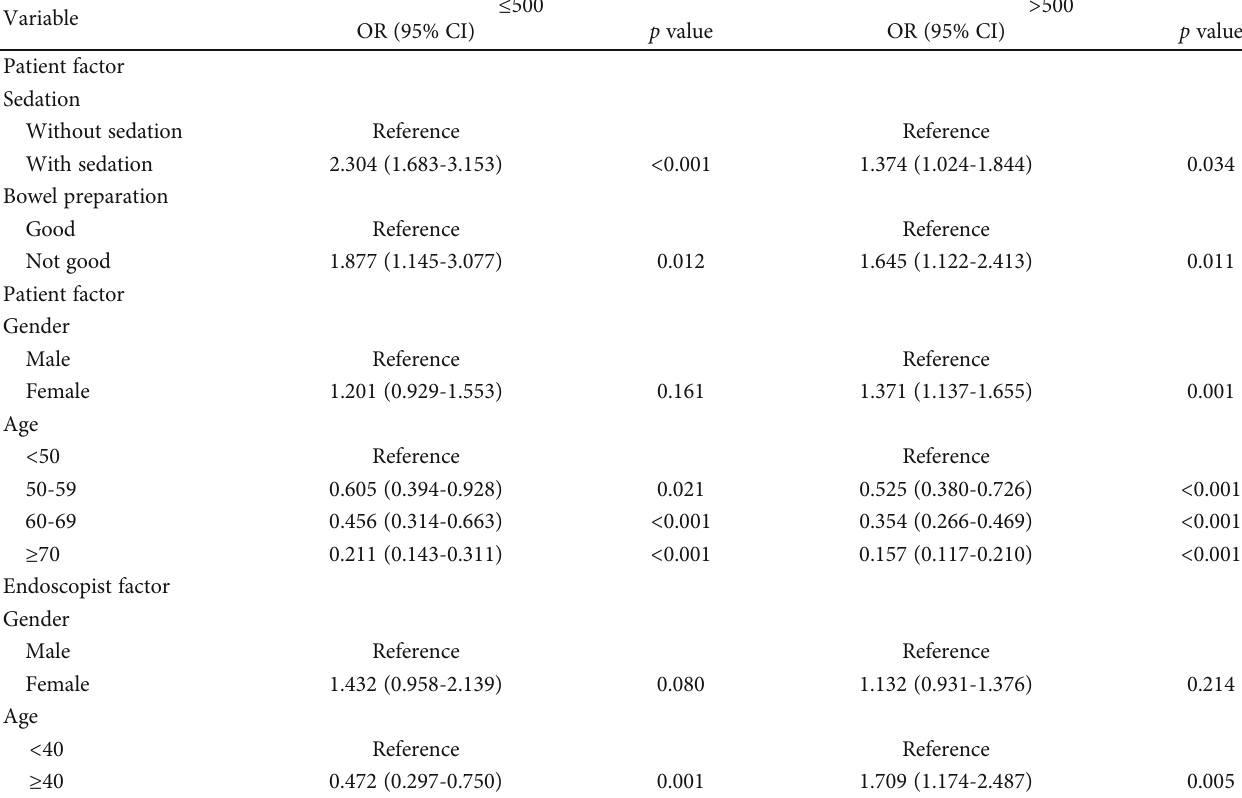
Table 5: Logistic regression analysis of risk factors for cecal intubation rate in subgroups strati fi ed by experience of